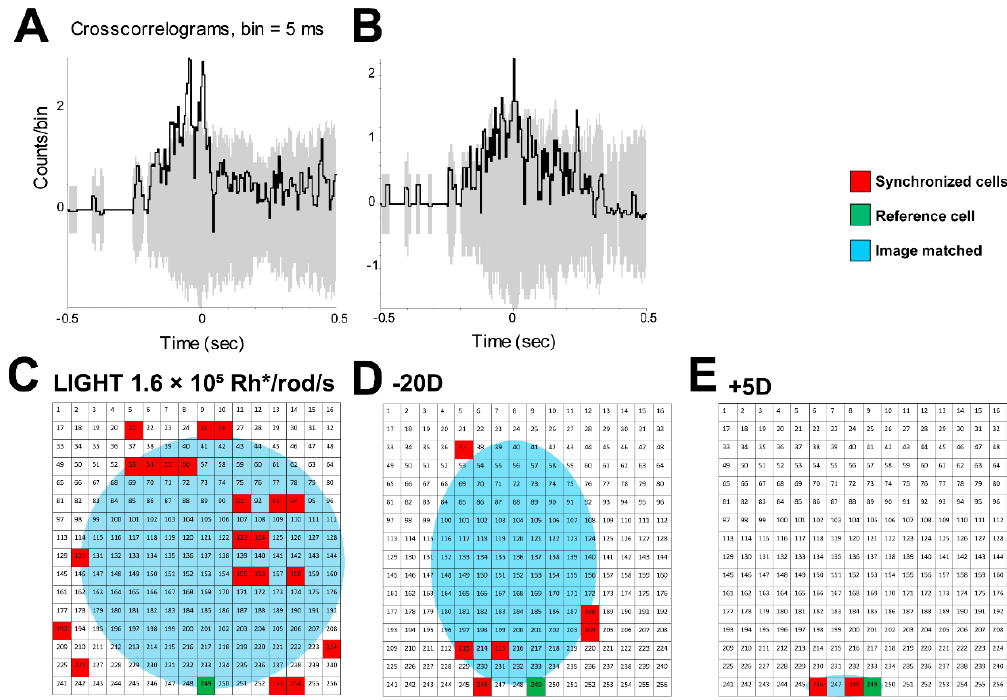
Figure 7. OFF-delayed RGCs/ displaced amacrine cell (dAC) synchronized firing may contribute to image edge detection. Two synchronized firing patterns ( A,B ) and the mapping of spatial firing pattern of focused image ( C ) and defocused image equivalent to − 20D ( D ) and +5D ( E ) dioptric power were shown. The green colored box represents the reference cell, whereas the red colored box represents the synchronized cells. The highlighted blue part is the representation of edge of the image. In this experiment, only OFF-delayed RGCs/dACs were mapped. The gray part in Figure 7A , B showed shift predictor cross-correlogram profiles computed from the pairs of OFF-delayed RGCs/dACs that had no coherent firing. The image was projected on the mouse retina with diameter 1.804 mm; spatial frequency 0 cycle/degree; light intensity 1.6 × 10 5 Rh*/rod/sec. MEA array size is 100/30 µm.